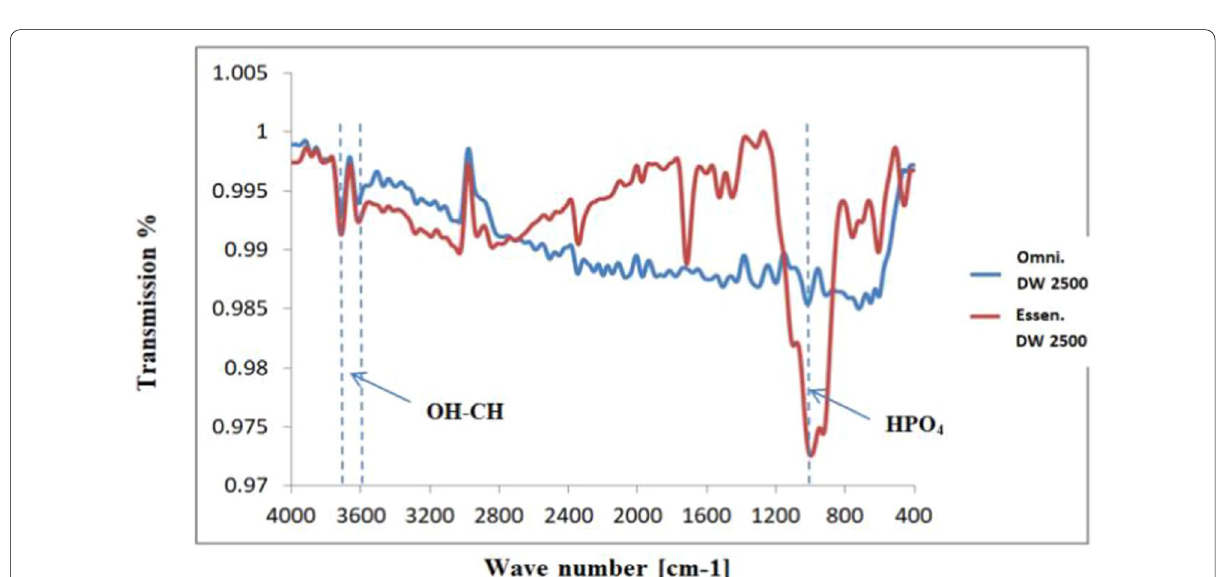
Fig. 6 FTIR spectra representing the chemical structure of Omnichroma DW 2500 and Essentia DW